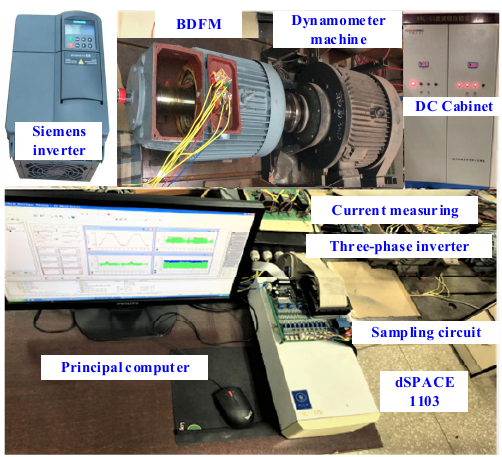
Figure 15. BDFM experimental platform.